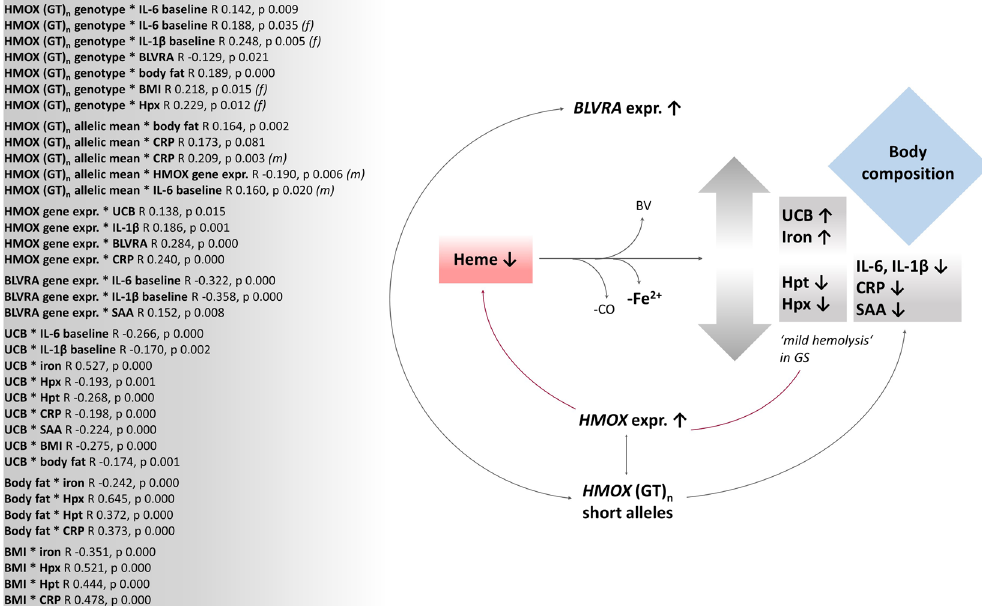
Figure 3. Graphical summary of inter-variable connections for the entire BiliHealth study population. Figure 3 illustrates statistical connections of variables of interest. Bivariate correlations were calculated for the entire study population using the model of Spearman’s rho. R coefficients and p-values (p ≤ 0.05) are presented in the box and are summarised in a graphical model. ( f ): effect valid for female subjects only; ( m ): effect valid for male subjects only. Abbreviations: UCB: unconjugated bilirubin; UGT1A1 : UGT1A1 genotype; IL-6/ IL-1 β : interleukins 6 and 1 β ; BLVRA expr.: genetic expression of biliverdin reductase; HMOX expr.: genetic expression of heme oxygenase; HMOX (GT) n : heme oxygenase GT fragment lengths expressed as genotype (short, medium, long) or as mean fragment length of the two alleles; Hpt: haptoglobin; Hpx: hemopexin; CRP: C-reactive protein; SAA: serum amyloid A; BV: biliverdin IX α ; CO: carbon monoxide; Fe 2 + : ferrous iron; BMI: body mass